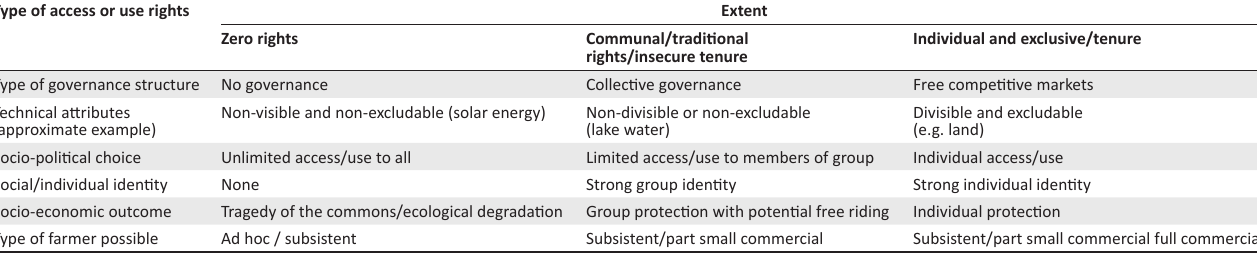
TABLE 1: Land rights ownership and use